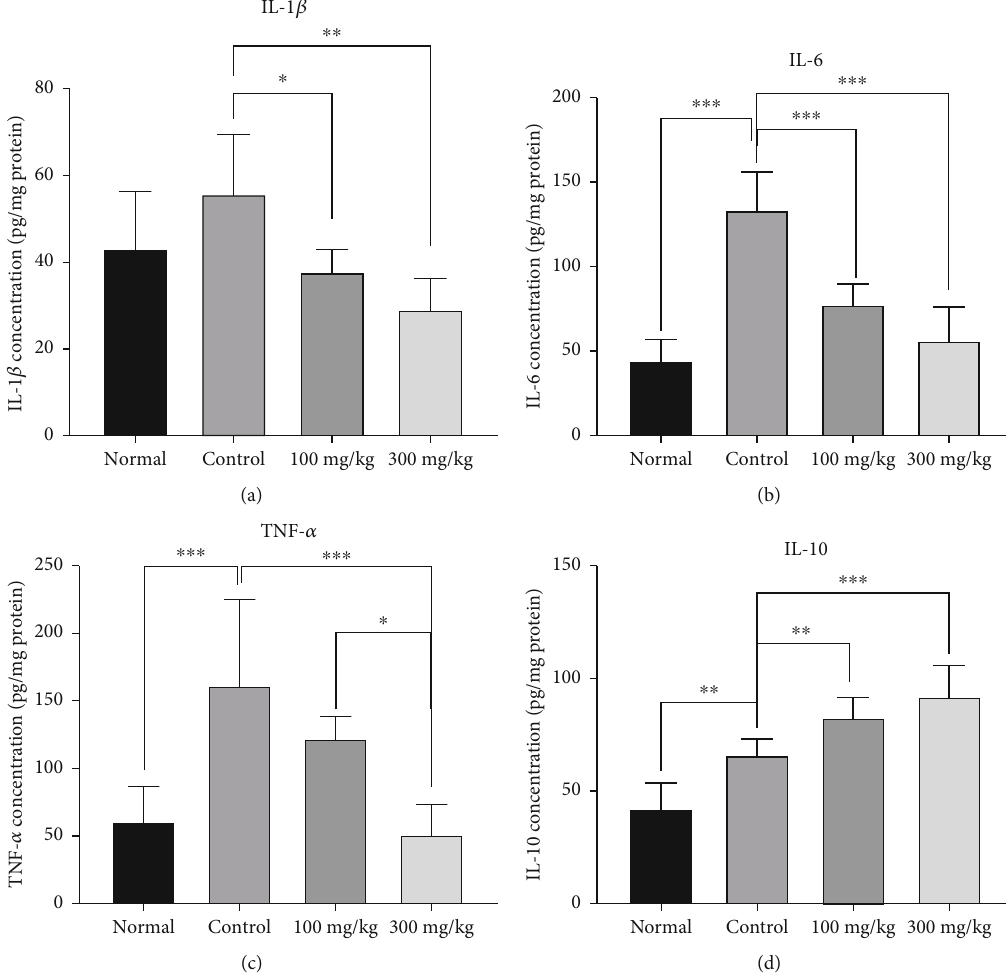
Figure 5: The e ff ects of di ff erent doses of PO on the peritoneal lavage levels of (a) IL-1 β , (b) IL-6, (c) TNF- α , and (d) IL-10; data were presented as mean ± SD ( n = 8 for all groups except normal as 6). ∗ P < 0 : 05 , ∗∗ P < 0 : 01 , and ∗∗∗ P < 0 : 001